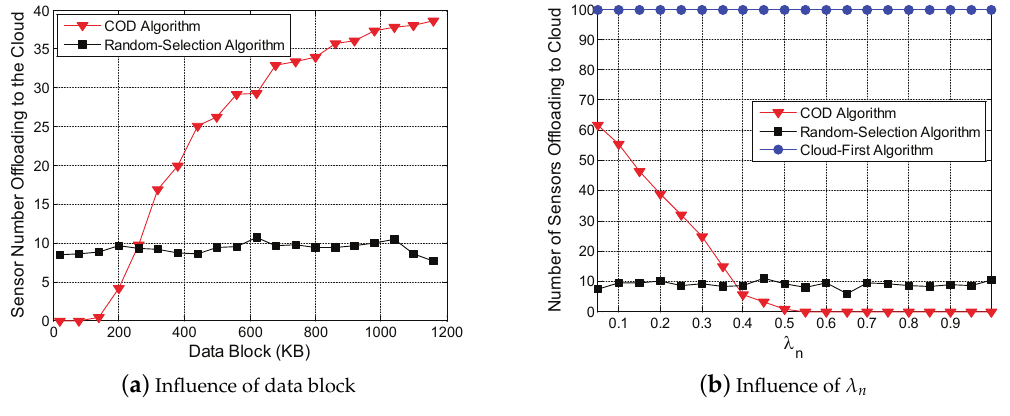
Figure 3. Influence of different